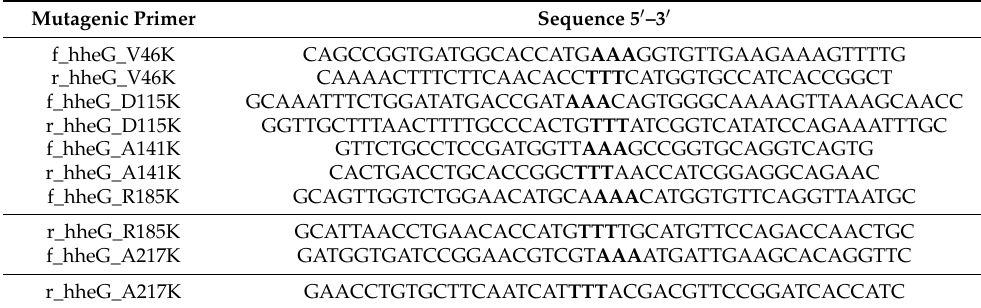
Table 2. Mutagenic primers used in this study. Nucleotide exchanges are shown in